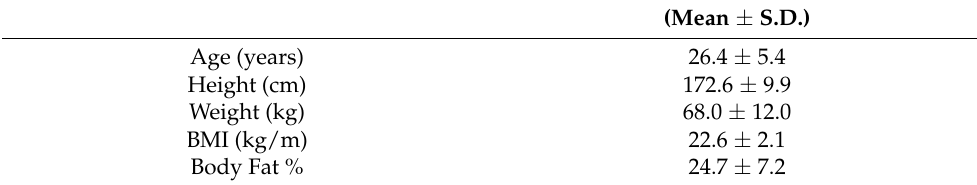
Table 3. Subject characteristics ( n =